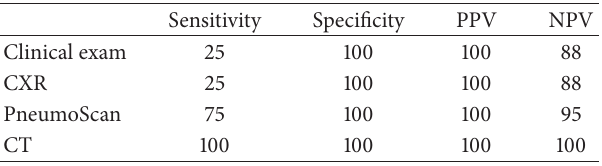
Table 3: Diagnostic value of investigated diagnostics; all data in